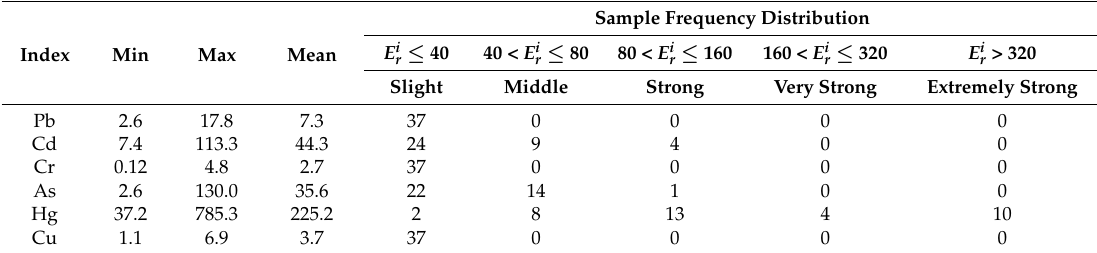
Table 7. Single heavy metal potential environment risk index ( E i r ) classification of P. notoginseng cultivation soil ( n = 37).